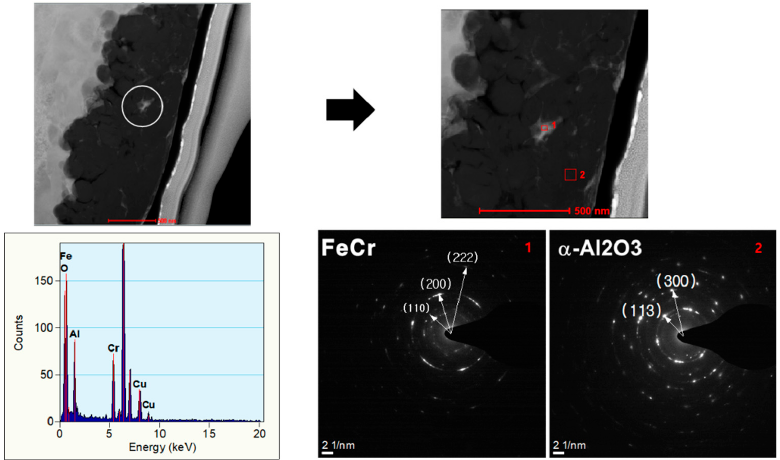
Figure 7. Cross-sectional selected area electron diffraction (SAED) analysis of a Fe-12.5%Cr CSSF.